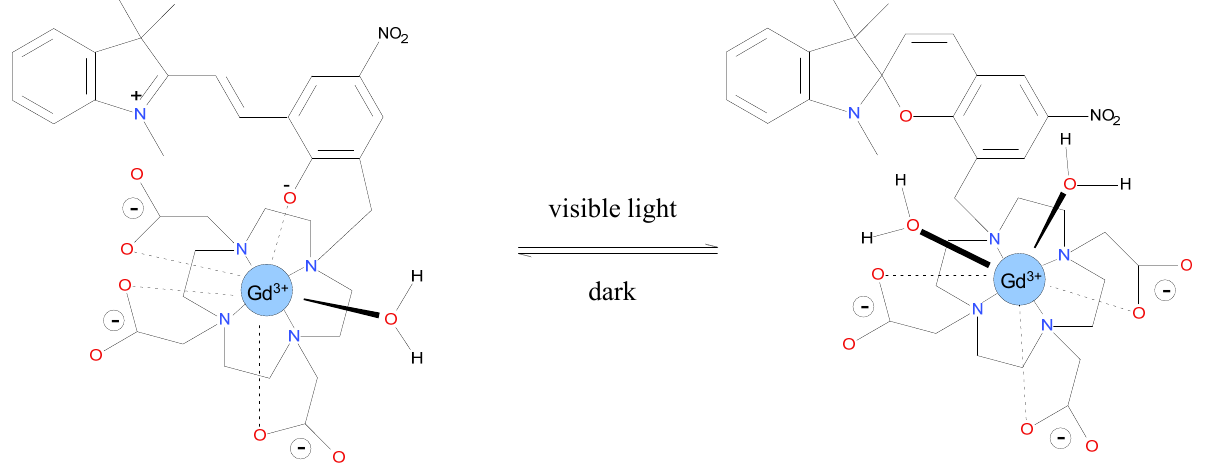
Scheme 1. Structural representation of spiropyran-DO3A-Gd(III): Proposed isomerization of the compound, displaying the two conformational states: merocyanine (left) and spiropyran (right). Under dark conditions, spiropyran-DO3A is preferentially in the merocyanine (MC) form, whereas visible light illumination leads to isomerization to the spiropyran form